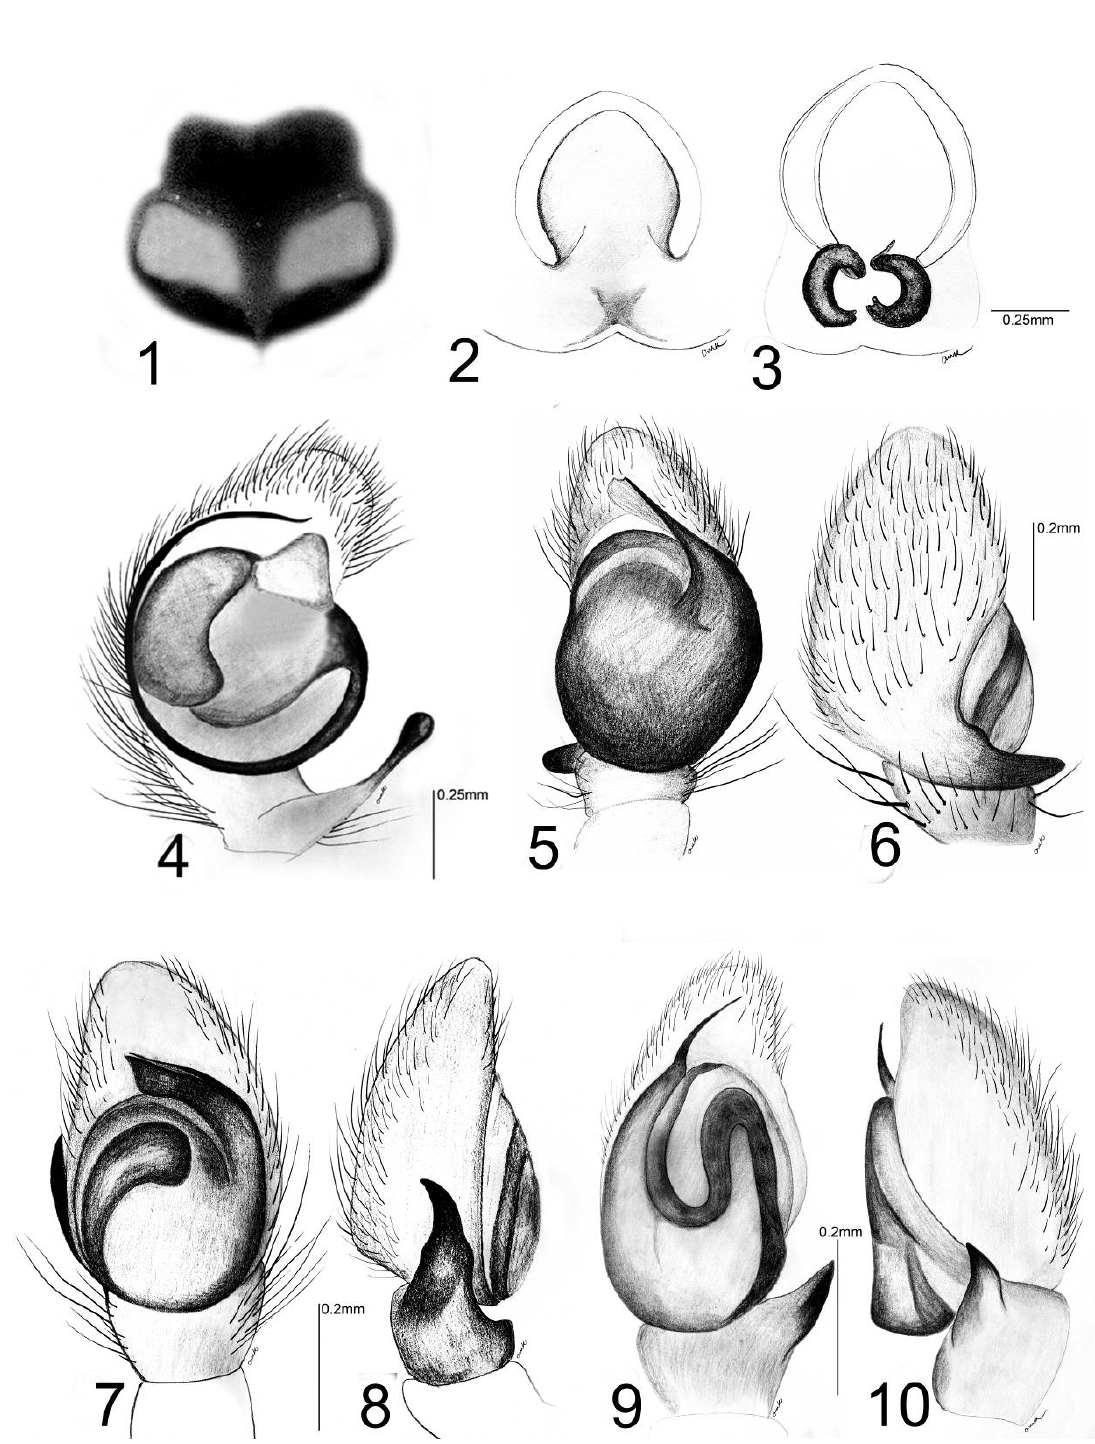
F IGURES 1-10. Mogrus antonius : 1) epigynum; 2) vulva; 3) male palp, ventral aspect; Pellenes bonus : 4) male palp, ventral aspect; 5) male palp, lateral aspect; P. geniculatus : 6) male palp, ventral aspect; 7) male palp, lateral aspect; Sitticus karakumensis : 8) male palp, ventral aspect; 9) male palp, lateral